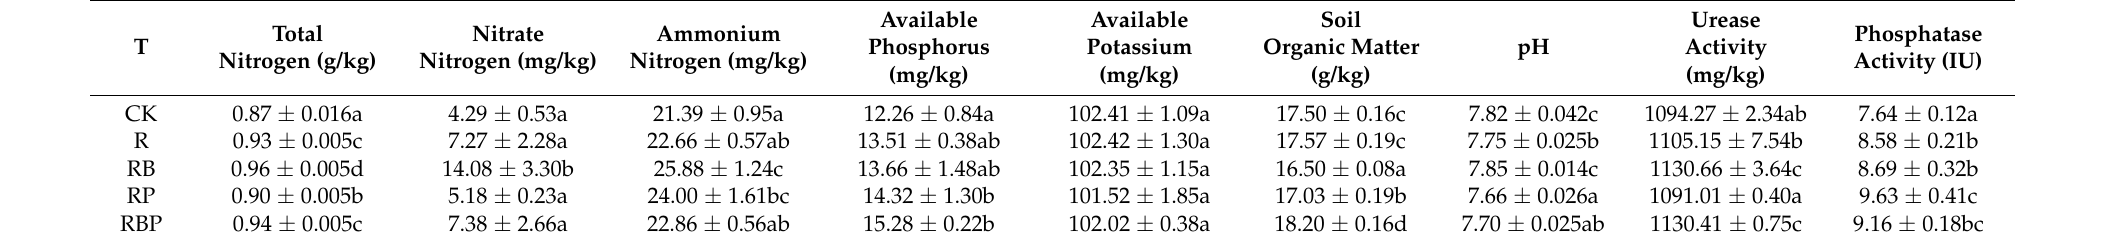
Table 2. Properties of rhizosphere